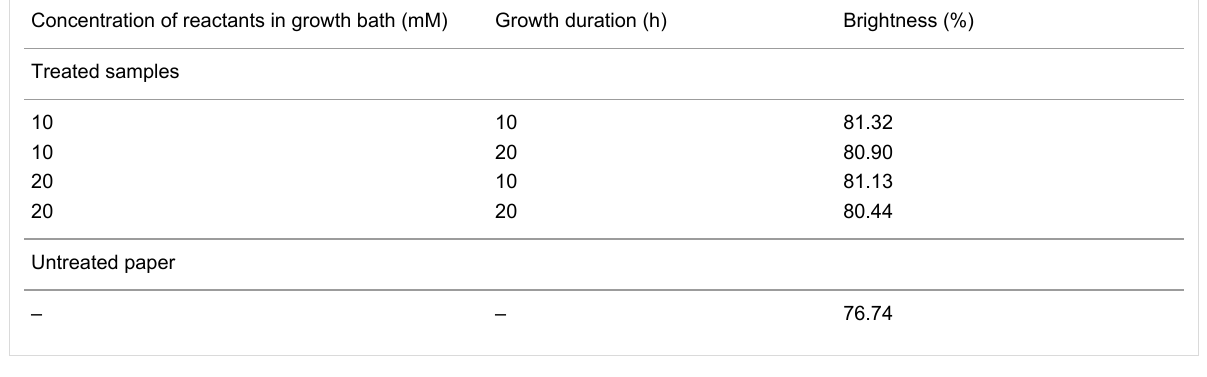
Table 2: Brightness of the paper samples with and without ZnO nanorods measured by using a Technidyne Color Touch PC. Concentration of reactants in growth bath (mM)